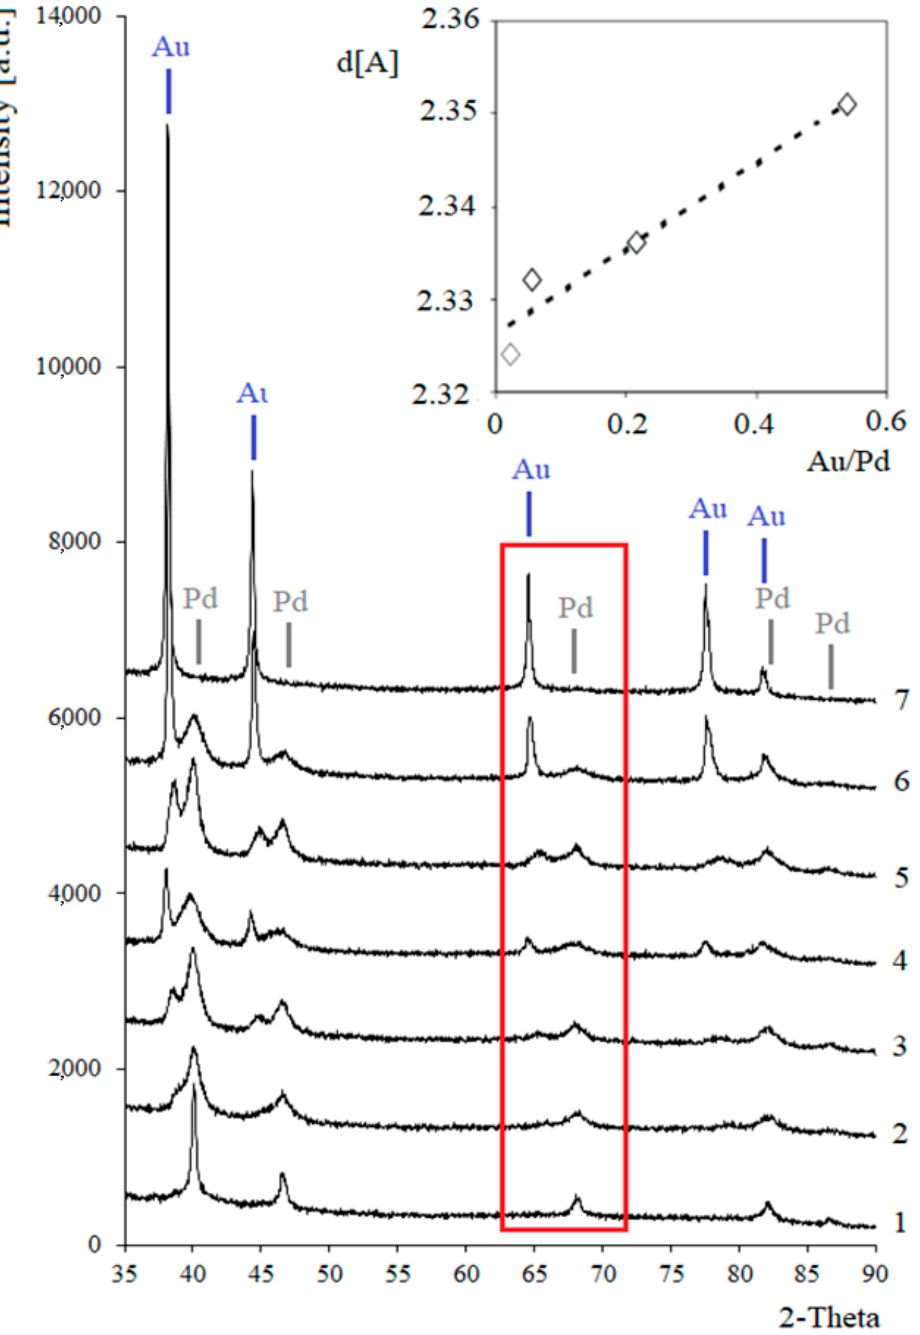
Figure 3. X-ray diffraction patterns for Pd-Au/SiO 2 catalysts: (1) 5% Pd/SiO 2 ; (2) 5% Pd-0.2% Au/SiO 2 ; (3) 5% Pd-0.5% Au/SiO 2 ; (4) 5% Pd-1% Au/SiO 2 ; (5) 5% Pd-2% Au/SiO 2 ; (6) 5% Pd-5% Au/SiO 2 ; (7) 5% Au/SiO 2 and the linear relationship of interplanar distances in the composition function of these systems (Vegard’s rule). The bimetallic catalysts were activated in a hydrogen atmosphere for 2 h at 300 ◦ C. Adapted from ref. [29].